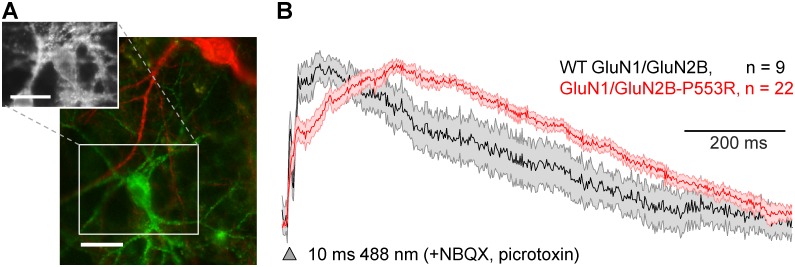
Effect of GluN2B-P553R on the NMDAR component of the EPSP.A, Red shows the presynaptic neuron expressing a channelrhodopsin variant (CheRiff) and green shows postsynaptic neuron transfected with GFP-GluN2B or GFP-GluN2B-P553R and a QuasAr voltage indicator (inset). Scale bars, 30 μm. B, Optically-evoked and optically-monitored EPSPs. The mean postsynaptic EPSP is given for neurons expressing GFP-GluN2B-P553R (red) or GFP-GluN2B (black). Shading represents s.e.m; n = number of neurons. EPSPs are shown normalized to peak (see Methods).